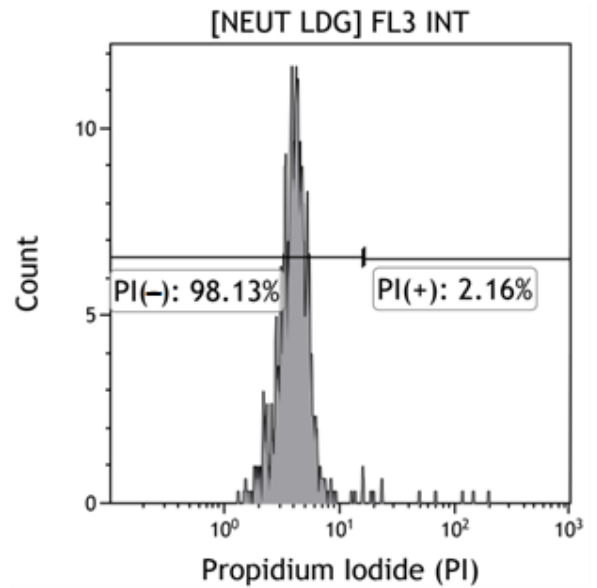
Figure 1. Viability of the LDG population. A-C Cytograms. The “PI − ” gate is the IP negative LDG population—the percentage of viable cells. The “PI+” gate is the population of dead cells (my own source). [Neut LDG] FL3 INT—[Low density granulocytes], a fluorescence channel on which the fluorescence of propidium iodide is induced.